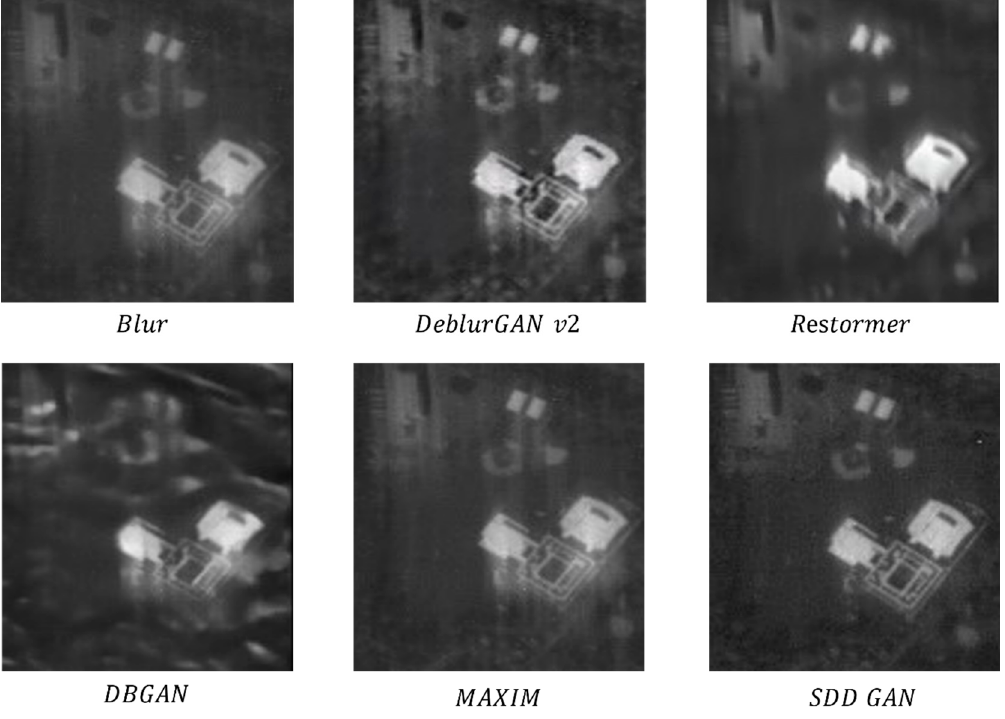
Figure 10. Test results for real satellite remote sensing blurred image.